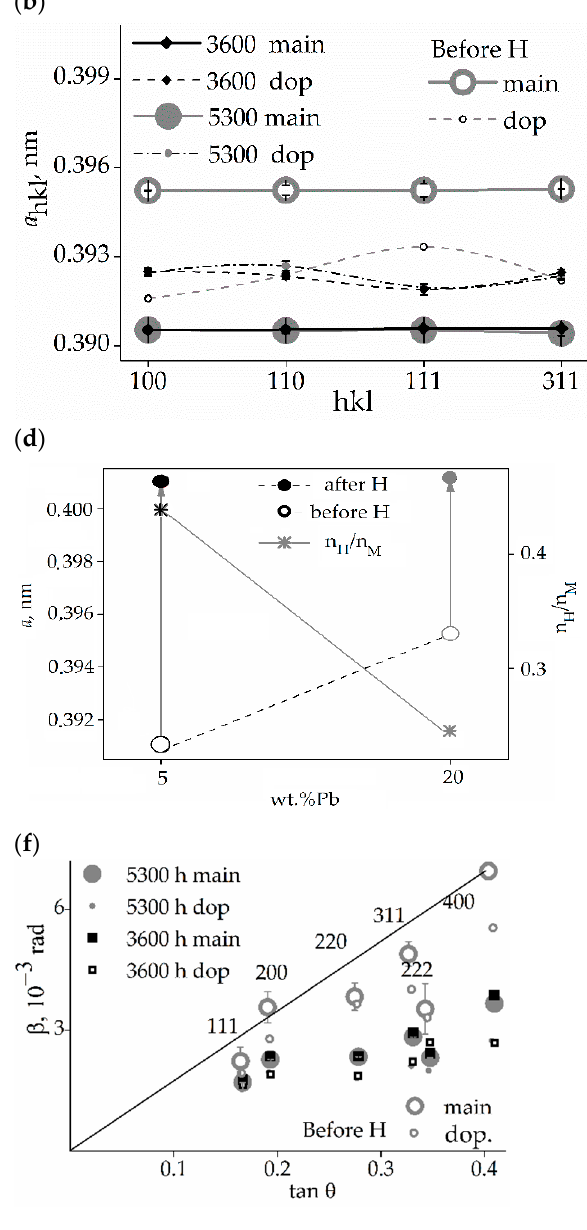
Figure 2. Parameters of elementary cells of the samples for states of relaxation after hydrogenation (before H, 3600 h; 5300 h): ( a , b )—5 and 20 wt.% lead, respectively, ( c )—the changes in angular position of reflections from CSR (311) и CSR (111) as a result of absorption/desorption processes; ( d )—the changes in the constant crystal lattice of alloys and the amount of absorbed hydrogen for the state of 24 h relaxation; ( e , f )—the physical broadening of diffraction reflections for the main phase of membranes 1 and 2 by the tan θ . Diffractograms of type I (2 θ ) (Figure 2c) show a shift of diffraction peaks from CSR (311) and CSR (111) towards a decrease in diffraction angles after hydrogenation (state of 24 h relaxation) compared with similar reflexes obtained for the state of samples before